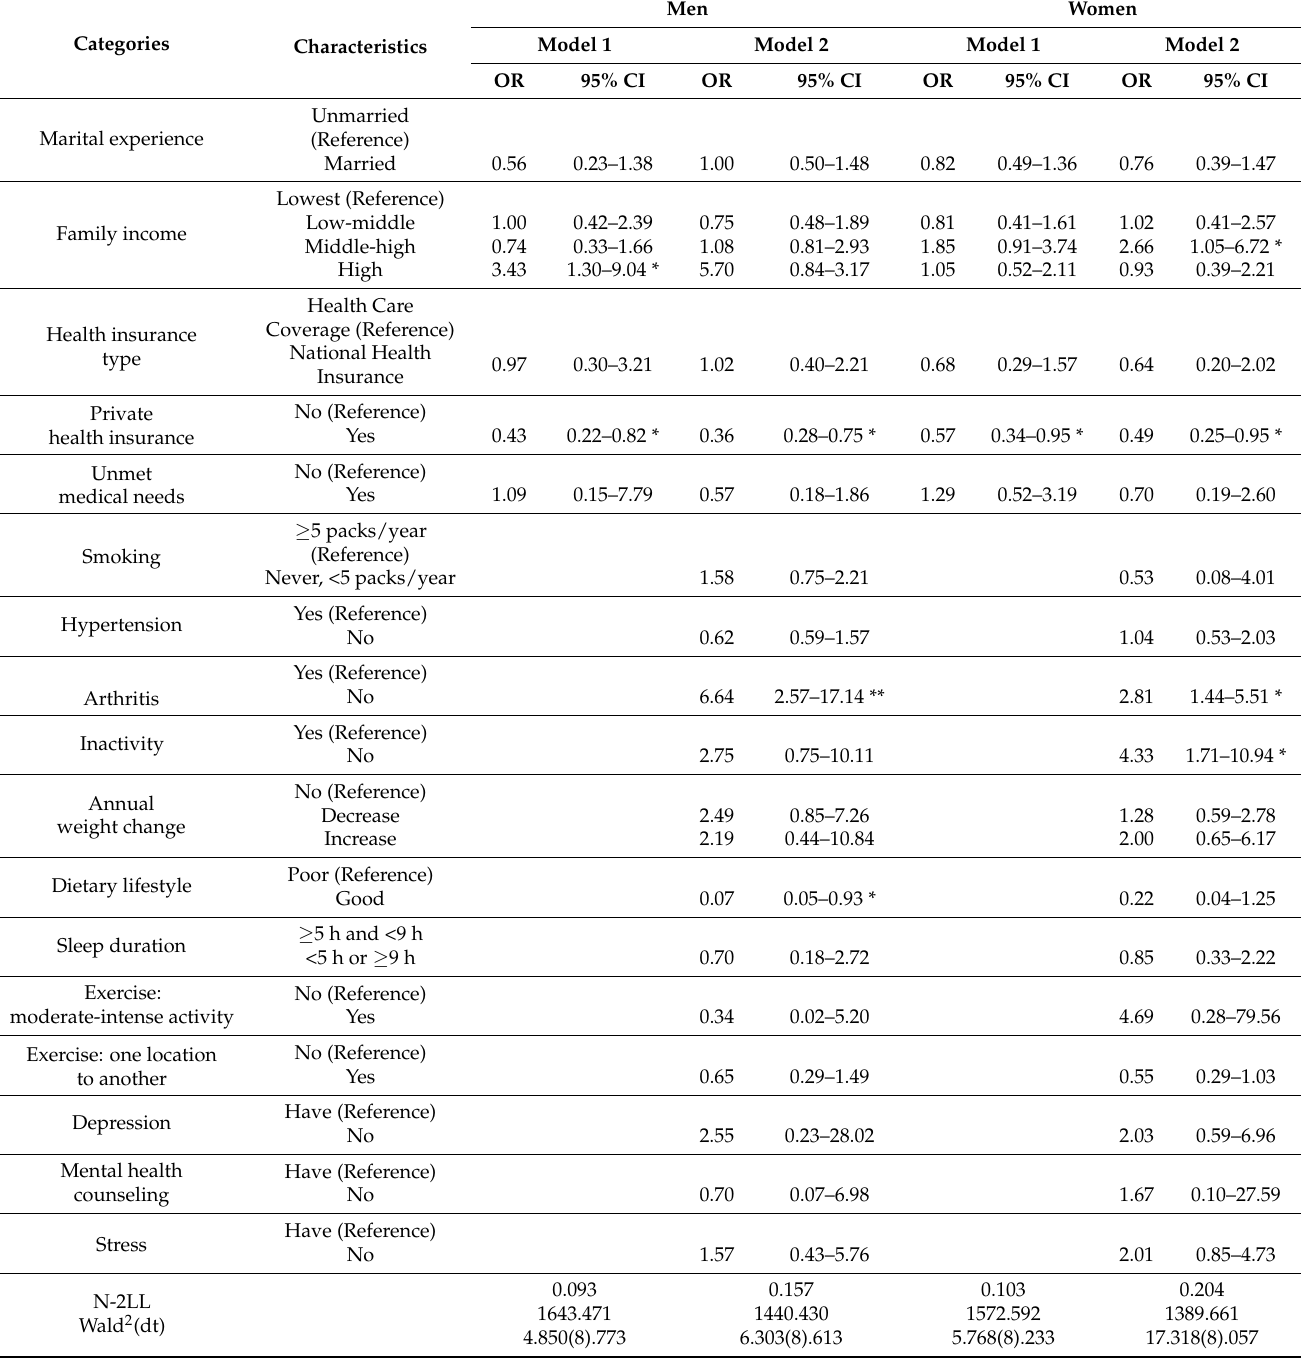
Table 3. Odds ratios and 95% confidence interval for the associated factors with impaired health related quality of life (EuroQol-5 dimension index score) by